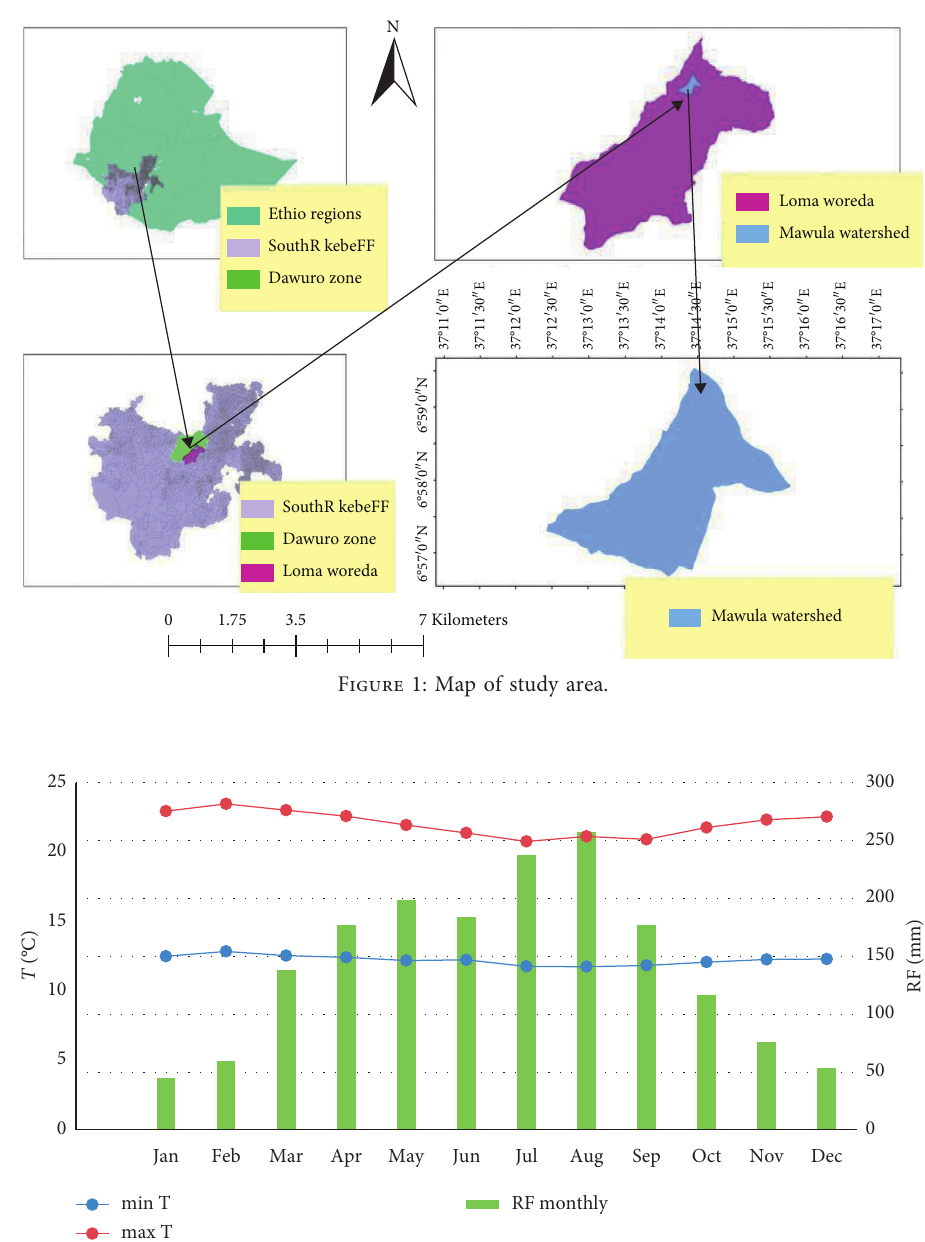
Figure 2: Monthly rainfall and maximum and minimum temperatures of the study area (11 years